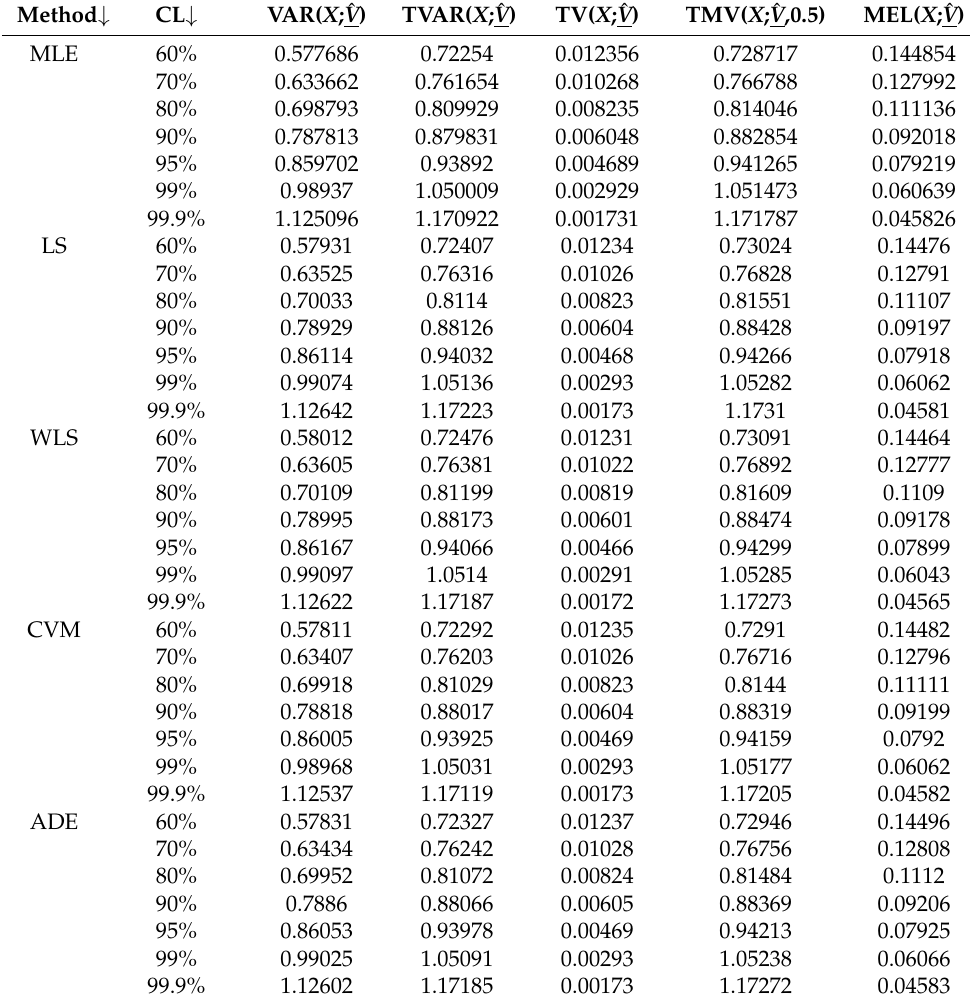
Table A3. The KRIs for the GRC under artificial data where n =